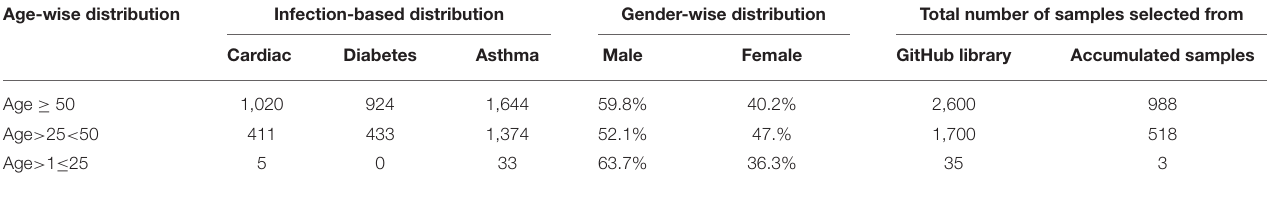
TABLE 1 | Details about the images database used for the experimental